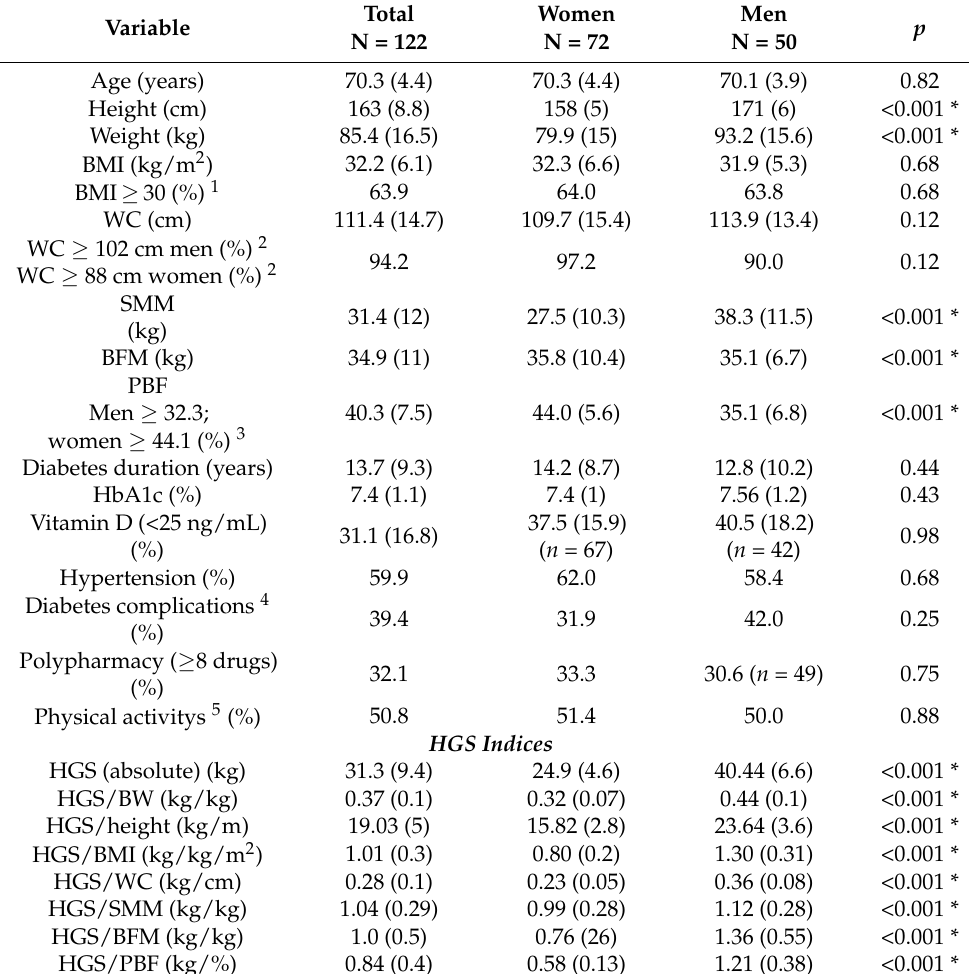
Table 1. Characteristics of study